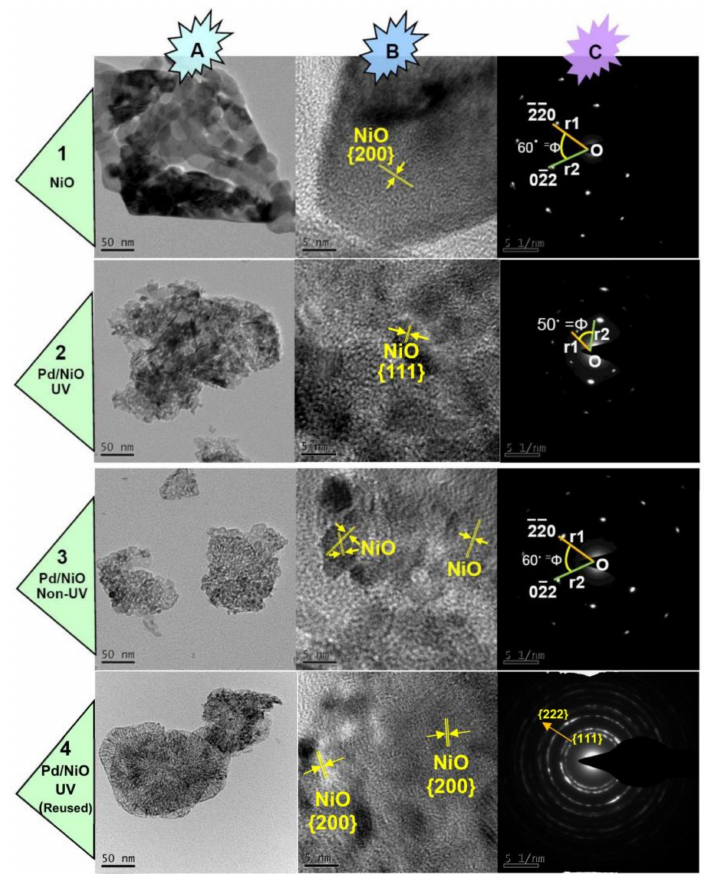
Figure 5. Transmission electron microscope (TEM, HRTEM) images (A n , B n ) and selected-area electronic diffraction (SAED) patterns (C n ) of varied samples including NiO and Pd-based catalysts (UV or non-UV irradiation, reused one after the fourth